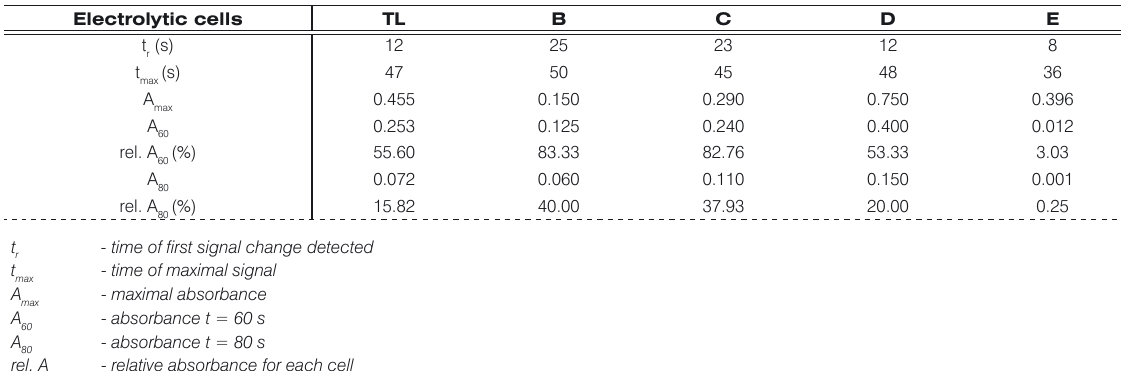
Table 3. Characteristics of FIA signal for each cell. Electrolytic